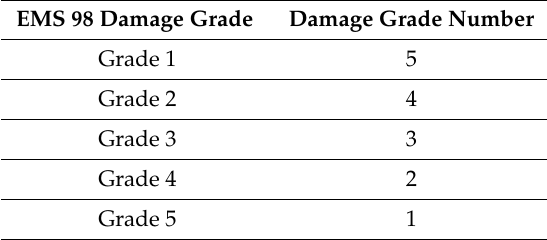
Figure 1. Location of Bingöl on the Turkey’s map [52]. . Table 14. EMS 98 damage grades as